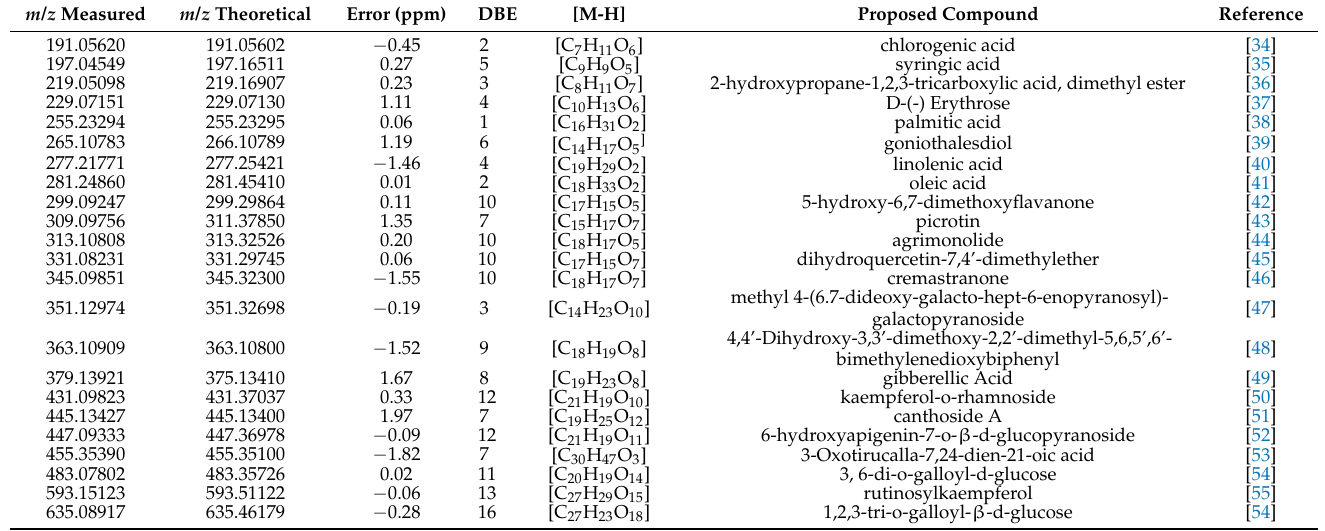
Table 6. Proposed structures by ESI (-) FT-ICR MS for the main molecules of Miconia chamissois crude